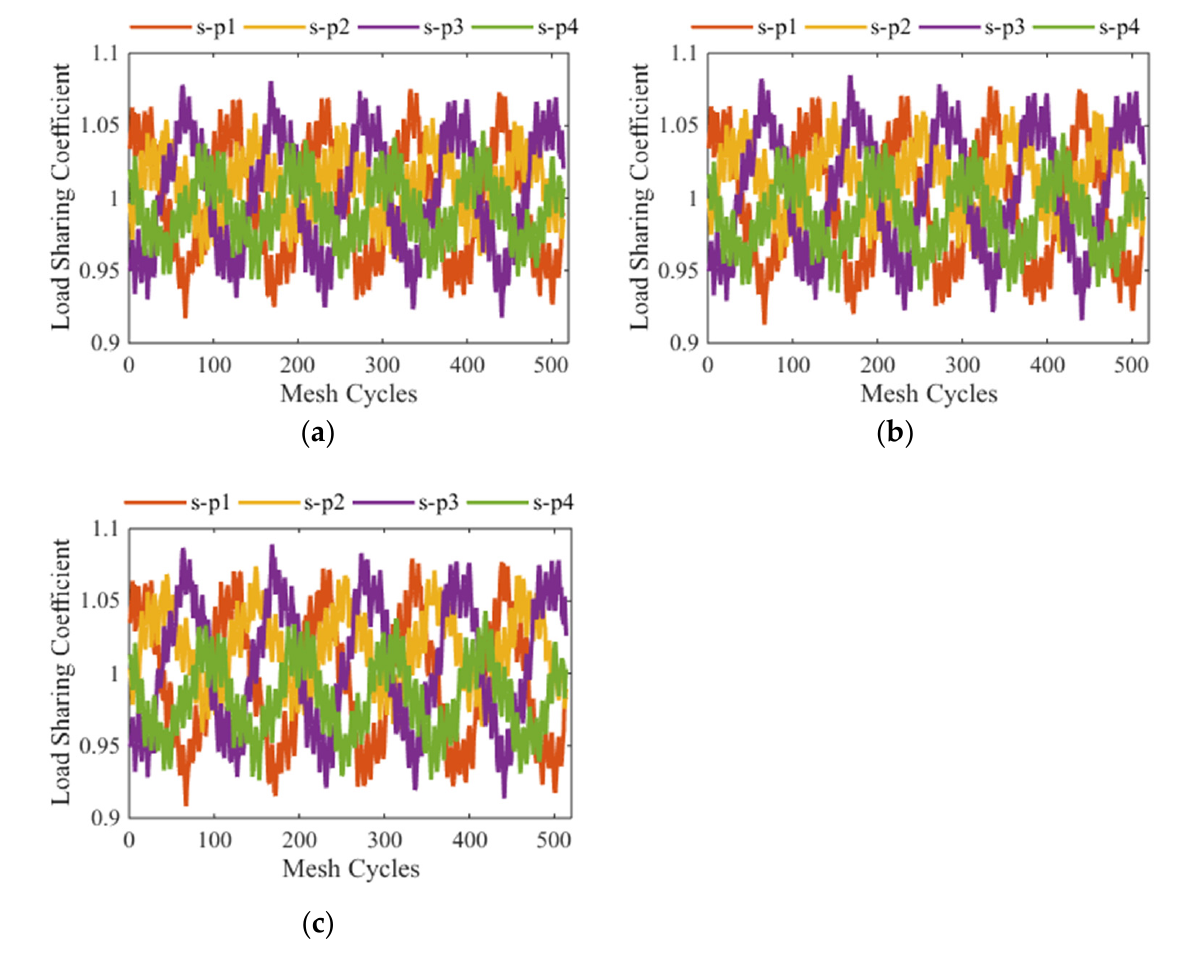
Figure 16. The LSC varies with the number of meshing frequency cycles under different LR. ( a ) LR = 40 m, LAV = 3 rad/s; ( b ) R = 70 m, LAV = 3 rad/s; ( c ) LR = 100 m, LAV = 3 rad/s.